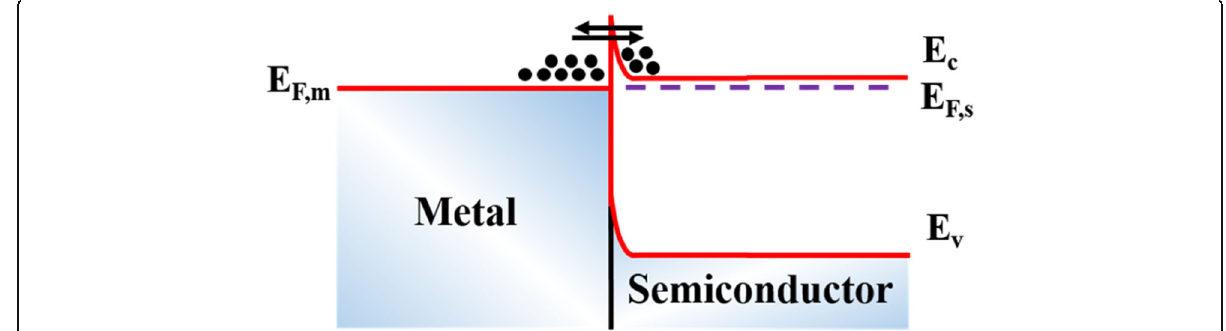
Fig. 2 The energy band diagram at the metal/semiconductor interface with highly doped semiconductors